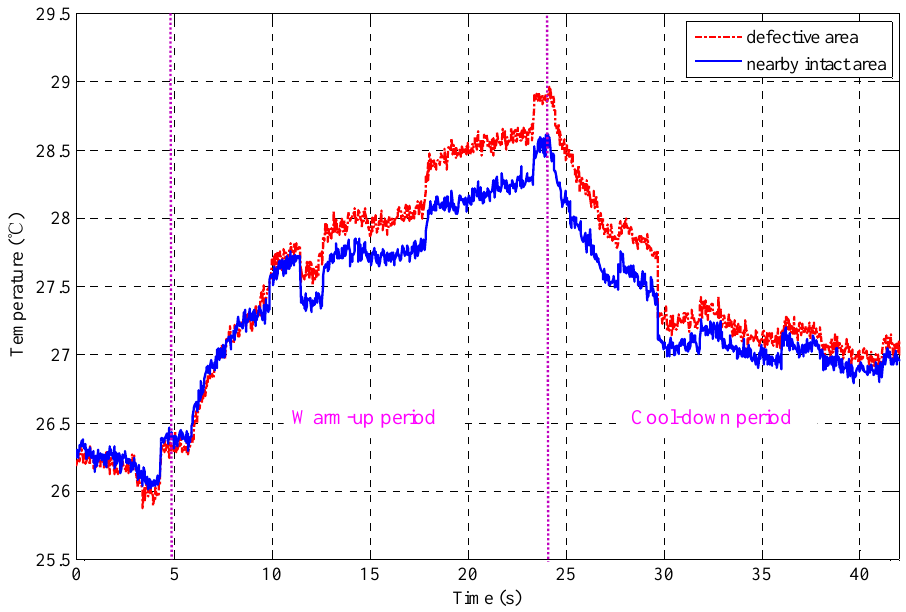
Figure 9. Temperature versus time in the defective area and nearby intact area.